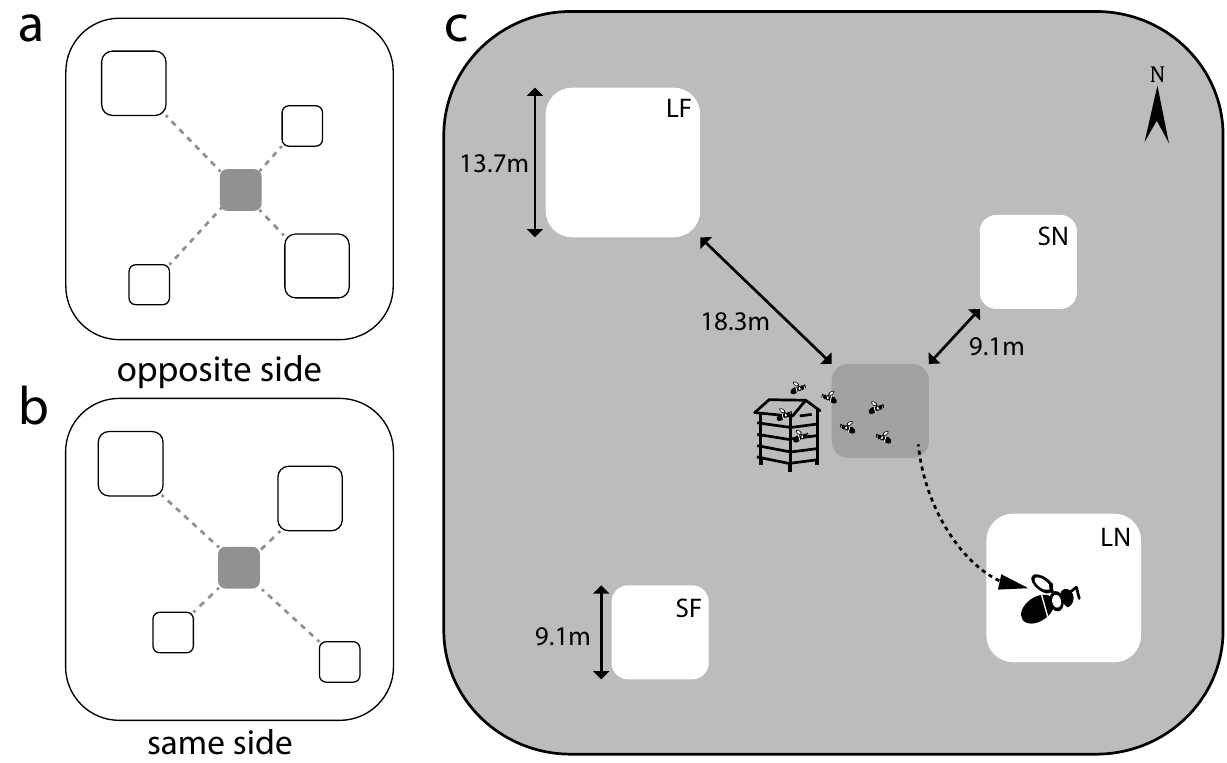
Figure 2. Configurations of the experiment and bee transitions. A center patch surrounded by four peripheral patches of two sizes and at two distances from the center were set up at different sites in two configurations, ( a ) an “opposite side” or ( b ) a “same side” configuration, referring to the location of patches of similar sizes relative to the center patch. ( c ) Bumblebee hives were positioned facing east along the center patch (dark grey) and bee transitions from the center to the peripheral patches (light grey) were recorded over two